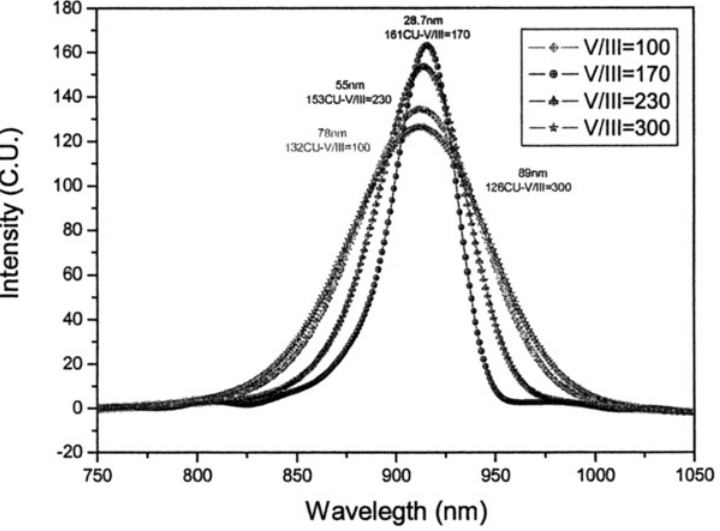
FIGURE 6 The different measured PL results by changing the V = III ratios with the growth temperature of 480 (cid:1) C at room temperature for the samples of direct growing InP on GaAs substrate using a constant growth rate of 25nm = min and a thickness of